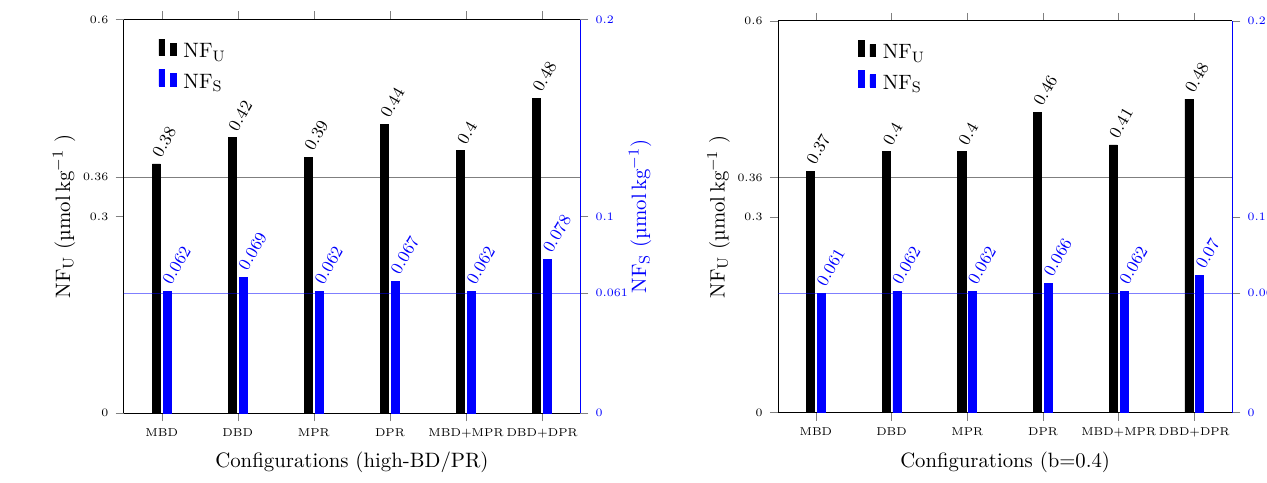
Figure 6. Sensitivity of simulated steady-state concentrations of ni- trogen fixers (NF U and NF S ) in the U and S boxes, respectively, after incorporating high-BD and high-PR. Horizontal grey and light blue lines represent the NF U and NF S concentrations in the control configuration.